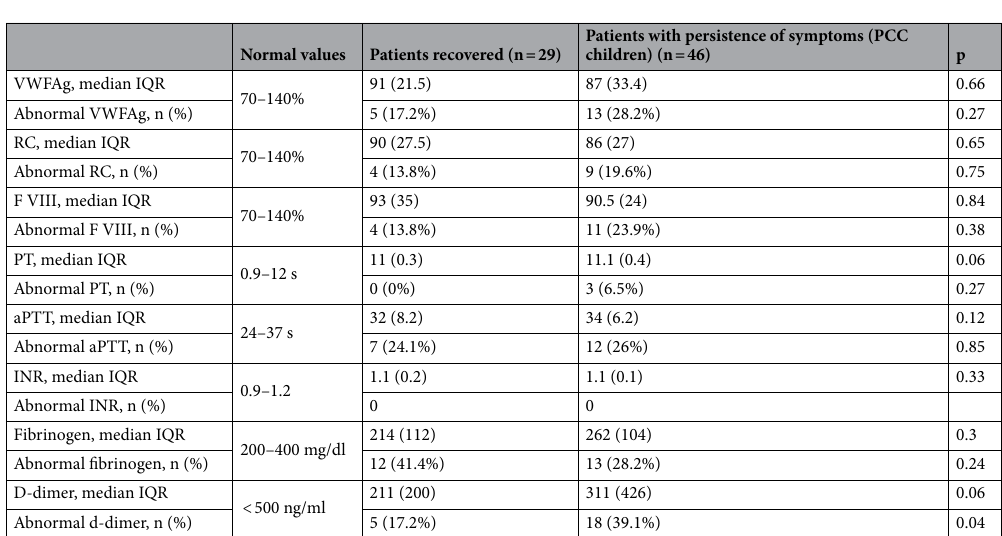
Table 2. Differences in the coagulation profile between patients with persistence of symptoms and patients recovered at follow-up. VWFAg von willebrand factor antigen, RC ristocetin cofactor, F VIII factor VIII, PT prothrombin time, aPTT activated partial thromboplastin